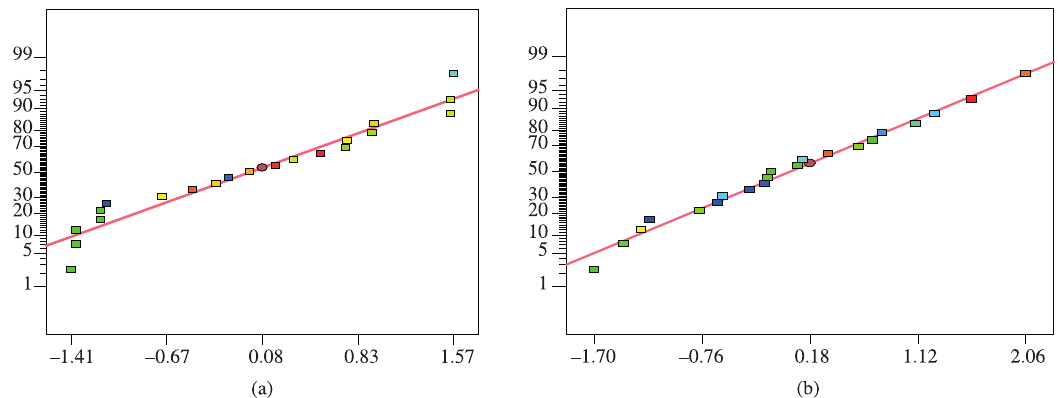
Figure 3. Normal plot of residuals for the quadratic model from the simplex-centroid design for (a) degree of conversion, (b) Vickers